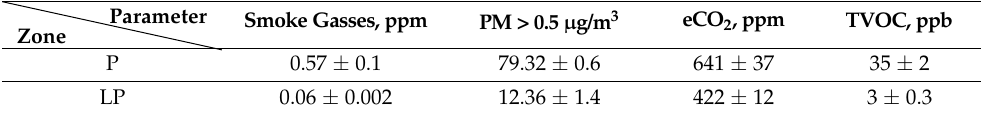
Table 2. Mean annual pollutants concentration for polluted (P) and less polluted (LP)